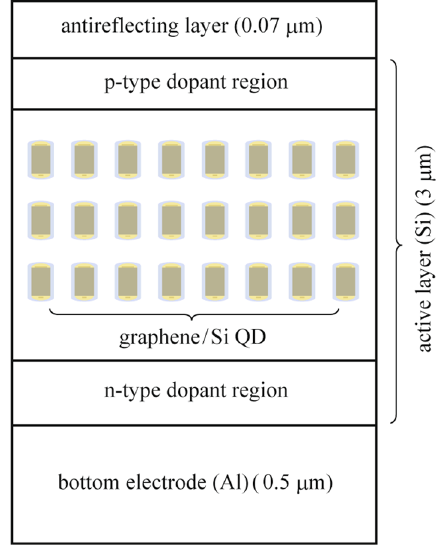
Fig. 3 Base structure of graphene/Si